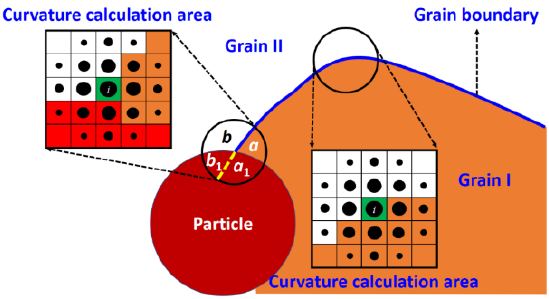
Figure 1. Diagrams of curvature calculation methods for the normal grain boundary and the grain boundary/particle junction.